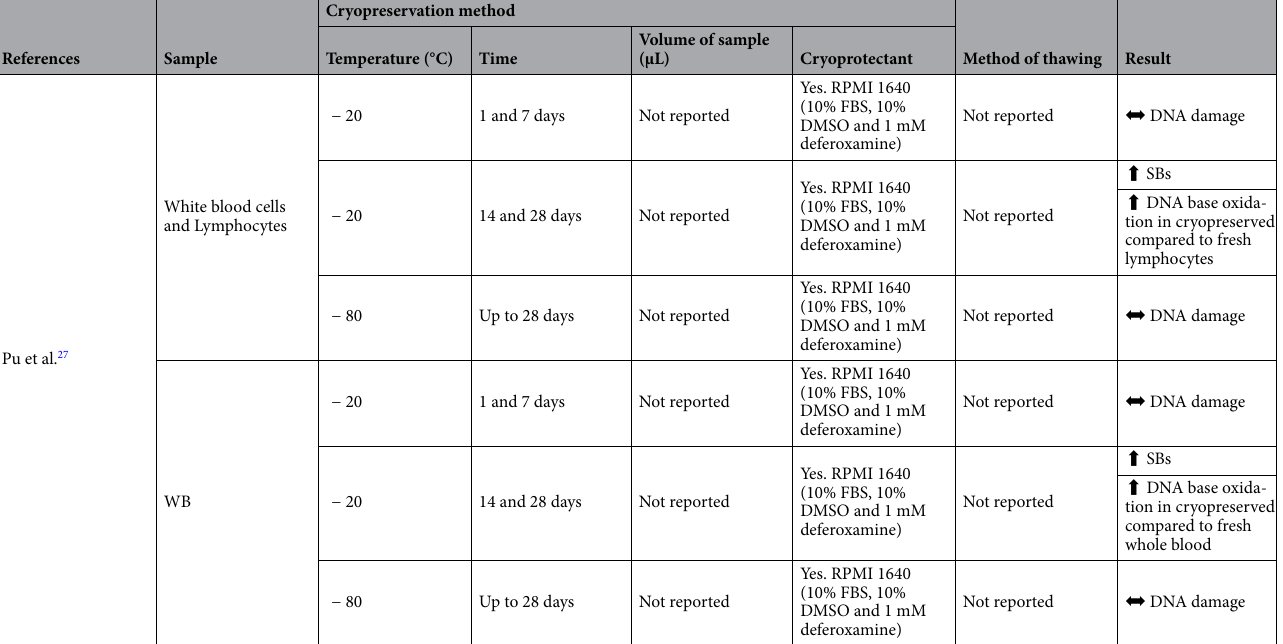
Table 1. Summary of the effect of cryopreservation on DNA damage performed by comet assay in whole blood and different isolated human cells. DMEM Dulbecco’s Modified Eagle Medium, DMSO dimethyl sulfoxide, FBS fetal bovine serum, Fpg formamidopyrimidine DNA-glycosylase, PBMCs peripheral blood mononuclear cells, SBs strand breaks, WB whole blood. ⬆ , statistically significant high levels; ⬌ , no statistically significant effect; ⬇ , statistically significant low